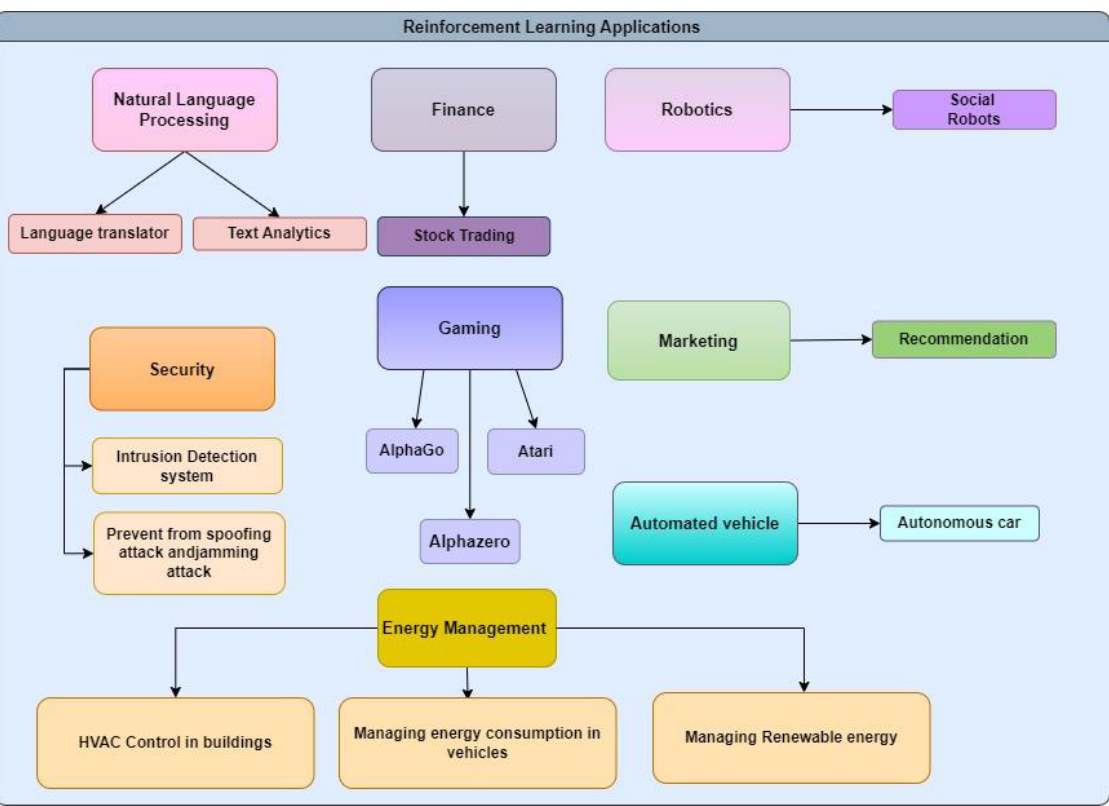
Figure 3. Overview of reinforcement learning applications .